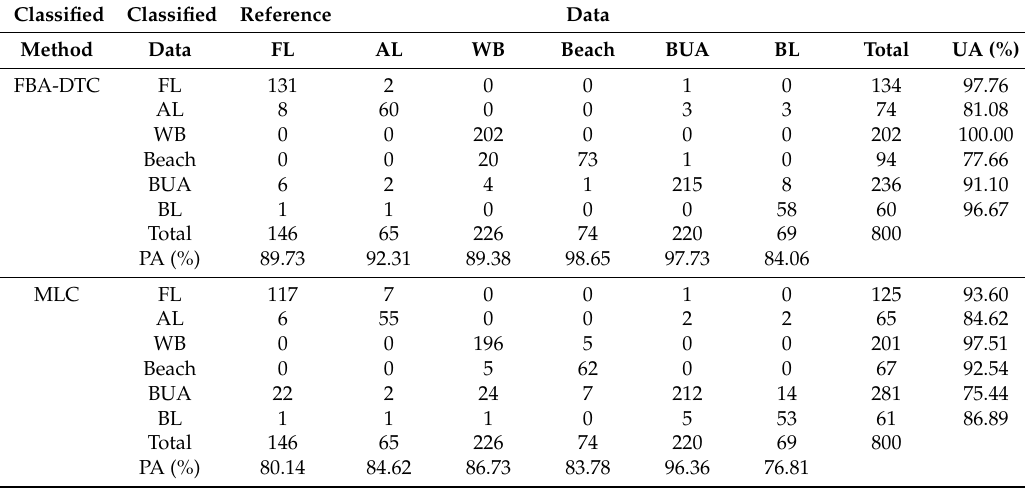
Table 4. Accuracy assessment of feature-based approach of decision tree classification (FBA-DTC) and maximum likelihood classification for the 2007 image. (See Table 3 for key to